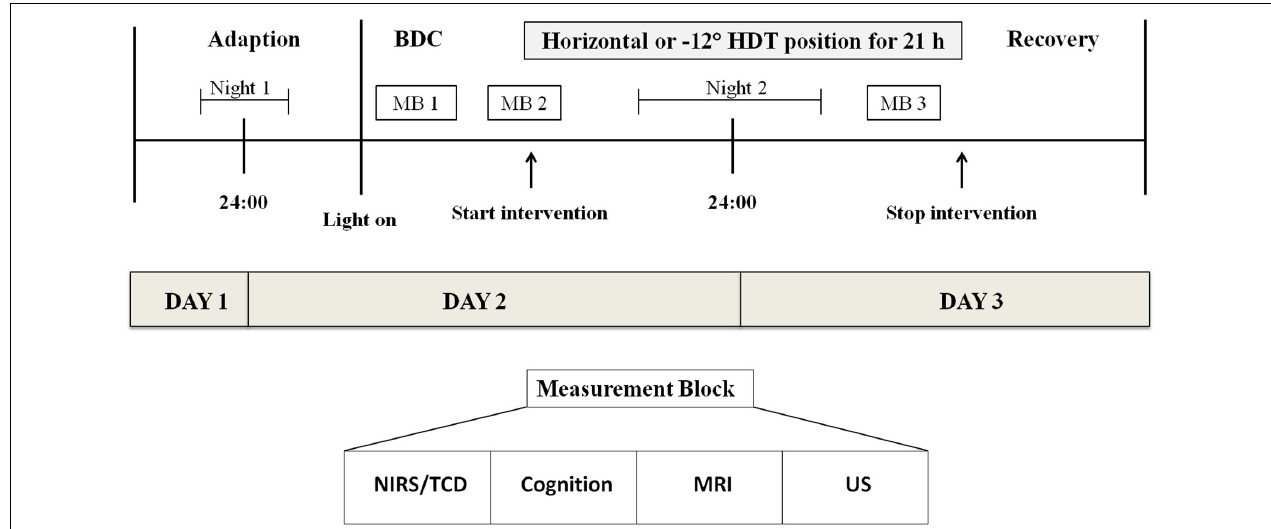
FIGURE 1 | Campaign overview. Each subject participated in two campaigns, once staying in horizontal posture and once being tilted to − 12 ◦ HDT. Between these two campaigns there was about a week’s time. Measurement blocks were carried out on both interventional days comprising five measurements. BDC, Baseline data collection; MB, Measurement block; NIRS, Near-infrared spectroscopy; TCD, Transcranial Doppler ultrasound of the mid-cerebral artery; CTB, cognitive test battery; MRI, (functional) magnetic resonance imaging; US, ultrasound of the jugular vein and facial thickness.